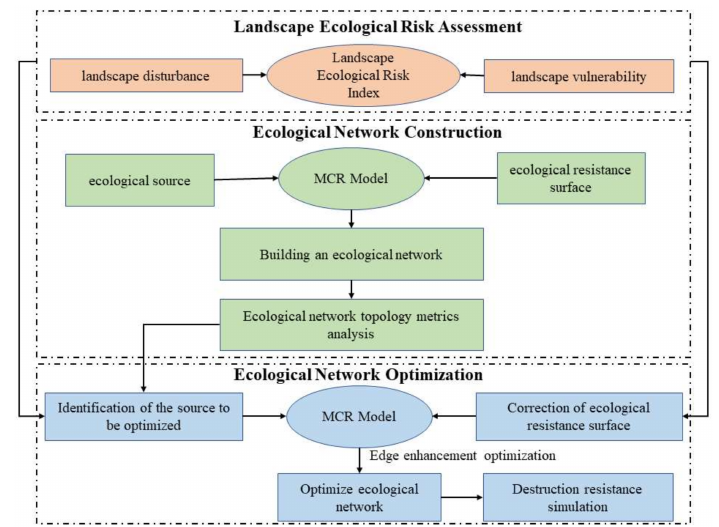
Figure 2. Schematic diagram of study